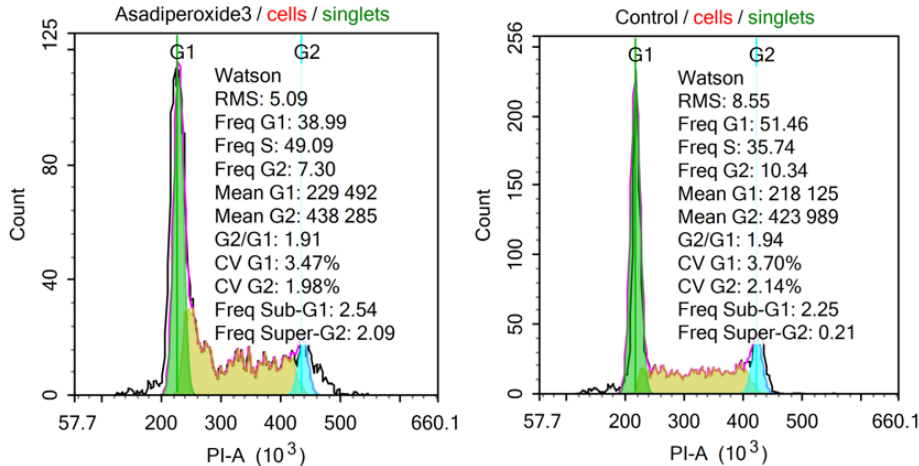
Figure 2. Cell cycle phases for Jurkat cells treated with azadiperoxide 3 at a concentration of 1.33 µ M. The incubation time of compounds with cells was 48 h. Propidium iodide